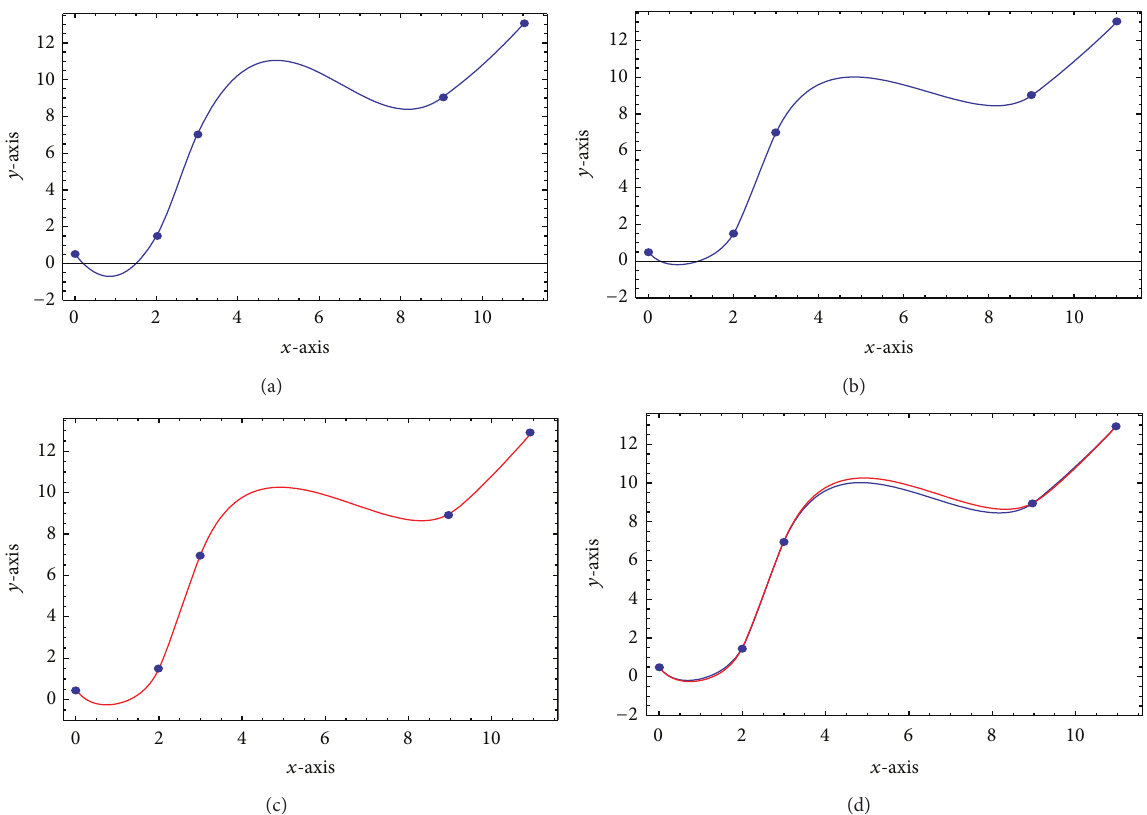
Figure 1: Interpolating curve for data in Table 1. (a) Default 𝐶 1 cubic spline with 𝛼 𝑖 = 𝛽 𝑖 = 1 and 𝛾 𝑖 = 0 . (b) 𝐶 1 rational cubic spline with = 𝛽 = 1 and 𝛾 = 2 . (c) 𝐶 2 rational cubic spline by using derivative calculated from tridiagonal equation (7) with 𝛼 𝛼 𝑖 𝑖 𝑖 (d) The graphs of (b) 𝐶 1 rational cubic spline (blue) and (c) 𝐶 2 rational cubic spline (red).